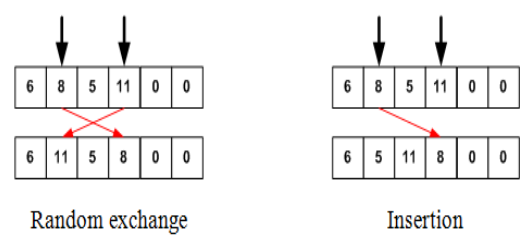
Figure 3: Mutation operators used in GA for CPP: the same route.